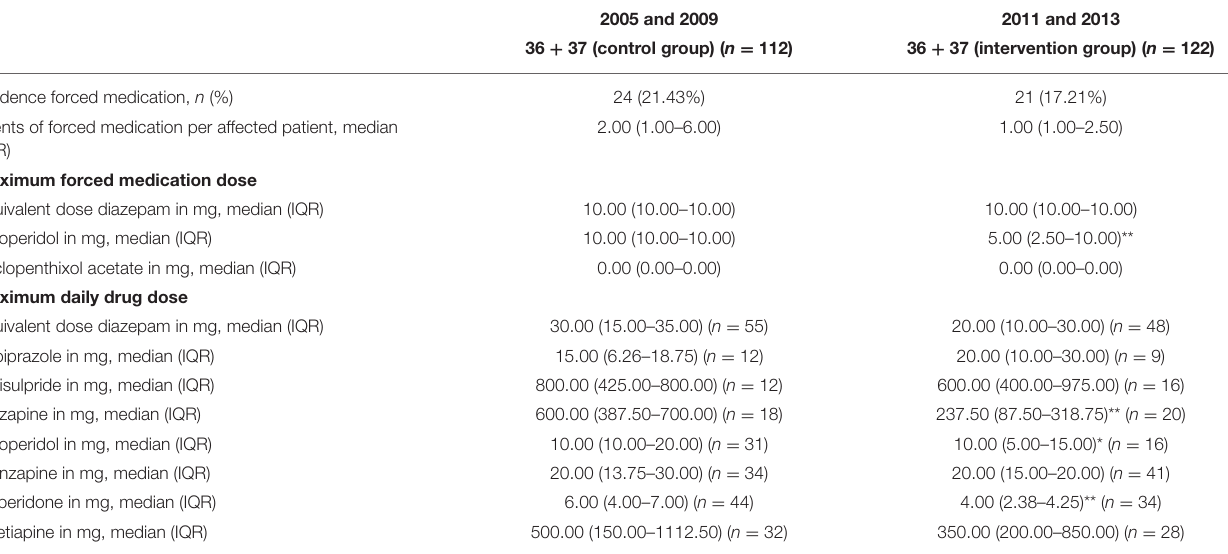
TABLE 2 | Group comparison of psychopharmacologic items and characteristics of coercion before and after implementation of the model ( n = 234) (* p < 0.05 and ** p <